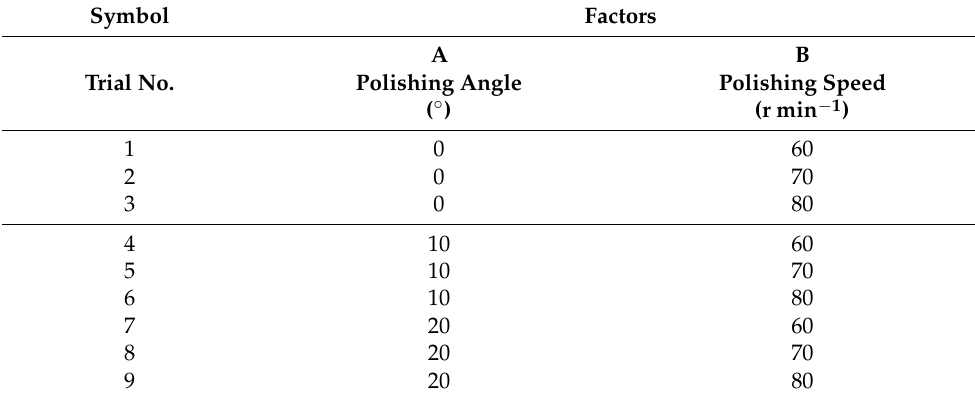
Table 3. L9 (3 2 ) Orthogonal experimental scheme.